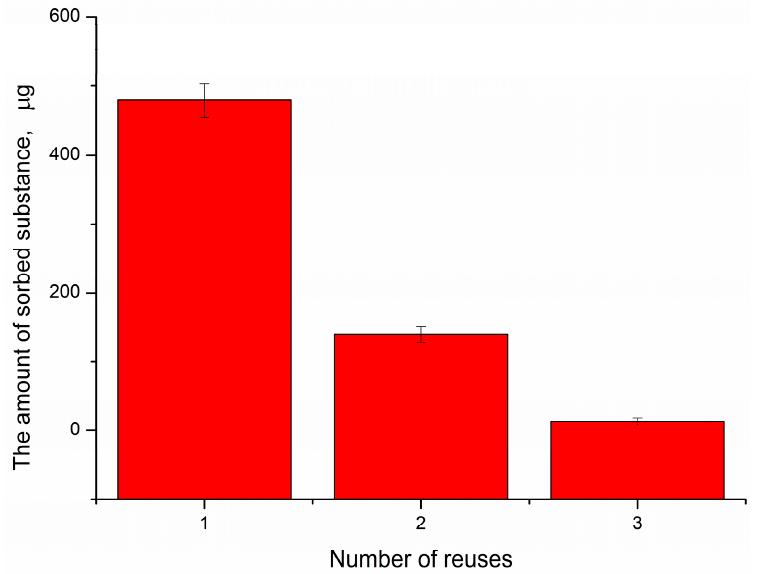
Figure 6. Change in the amount of adsorbed K 3 [Fe(CN) 6 ], depending on the number of repeated incubations with PMC.